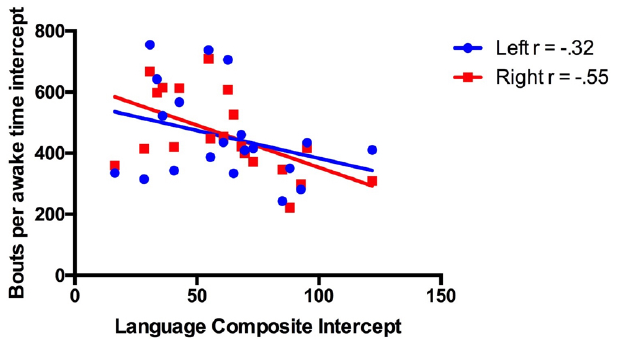
Figure 7. Scatter plot of mean average acceleration (MAA) intercepts (for right and left arms) and Bayley composite motor intercepts of each infant.